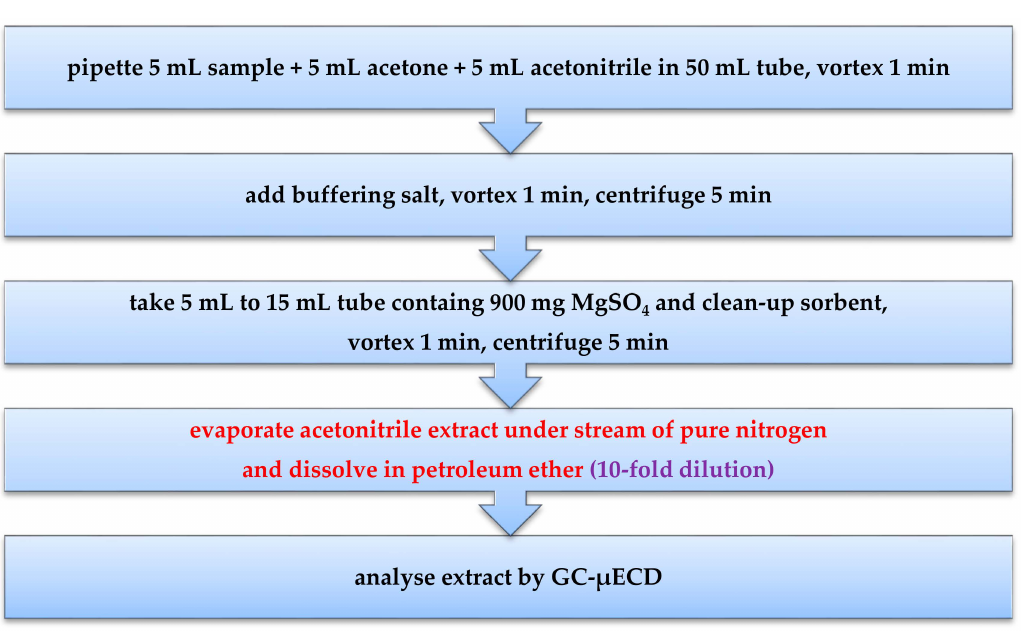
Figure 8. Scheme of real industrial wastewater sample